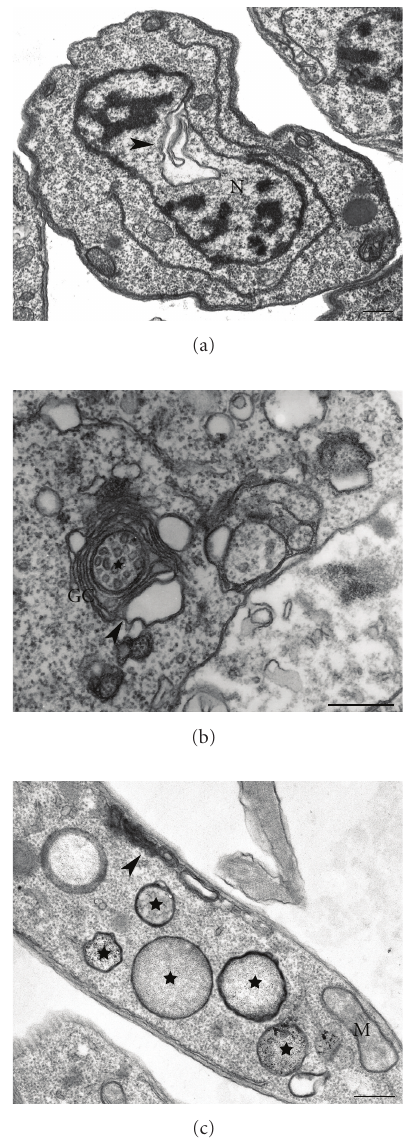
Figure 7: L. amazonensis promastigotes treated with azasterols (a)-(b), and ER-119884 (c) showing alterations in the nuclear membrane ((a), arrowhead ), in the Golgi complex ((b), arrow- head ), and in the endoplasmic reticulum ((c), arrowhead ). In the Figures 6(b) and 6(c), the presence of a multivesicu- lar bodies and autophagosome-like structures ( stars ) could be related with a remodeling process of damaged organelle by autophagy. GC, Golgi complex; M, mitochondrion; N, nucleus. Bars, 0 . 5 μ